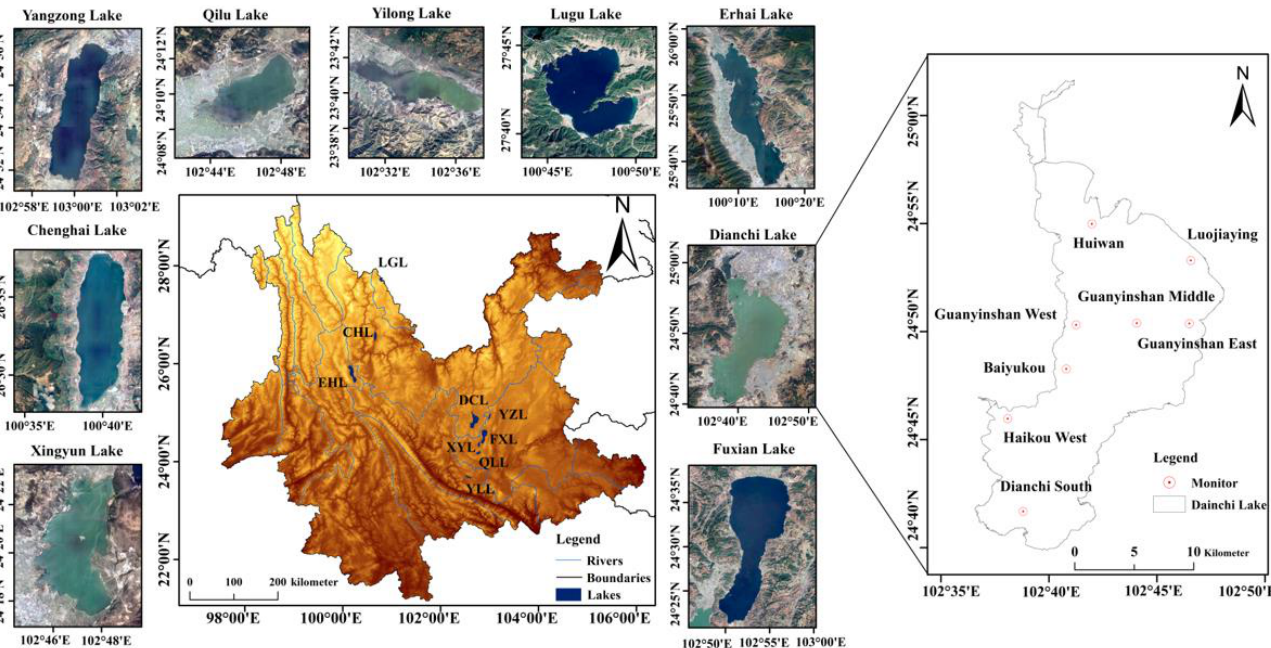
Figure 1. Satellite images of Nine Plateau Lakes, their geographical locations, and the monitoring station of Dianchi Lake.